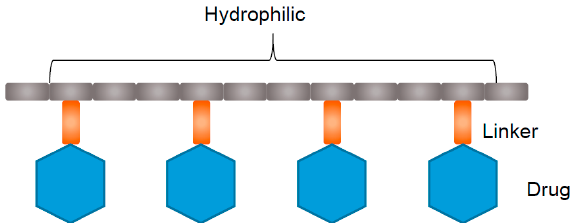
Figure 2. Schematic representation of a polymer drug conjugate.